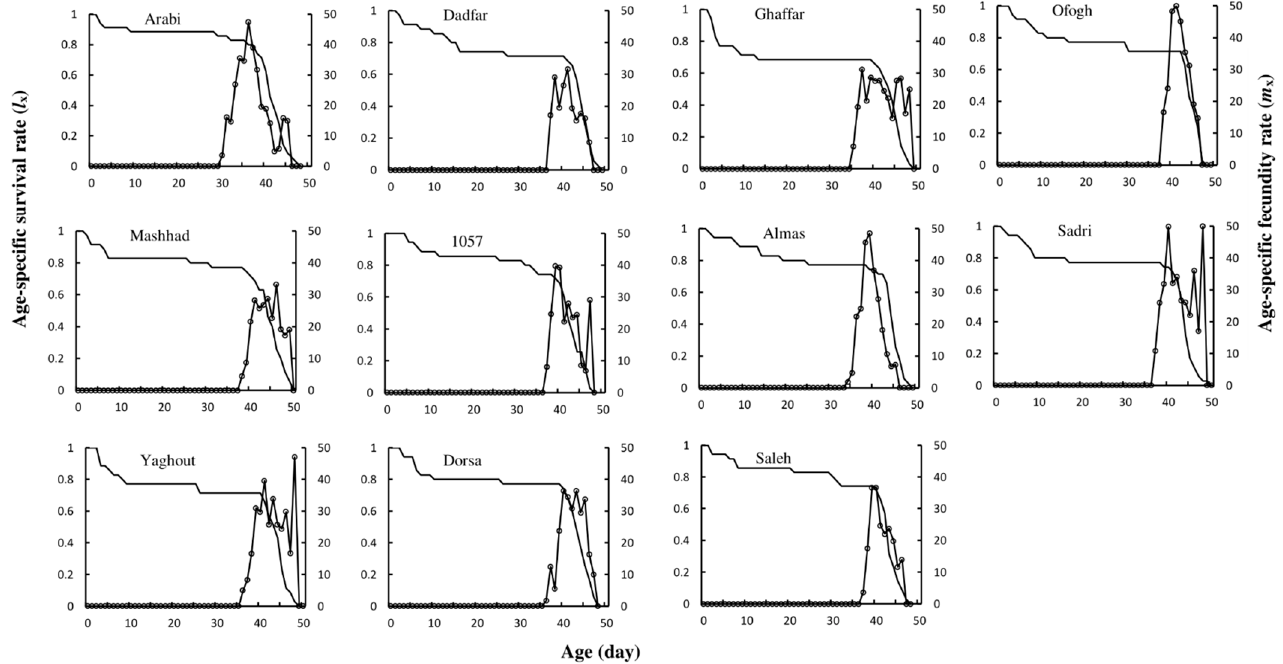
Figure 1. Age-specific survival rate ( l x ) and age-specific fecundity ( m x ) of Spodoptera littoralis on